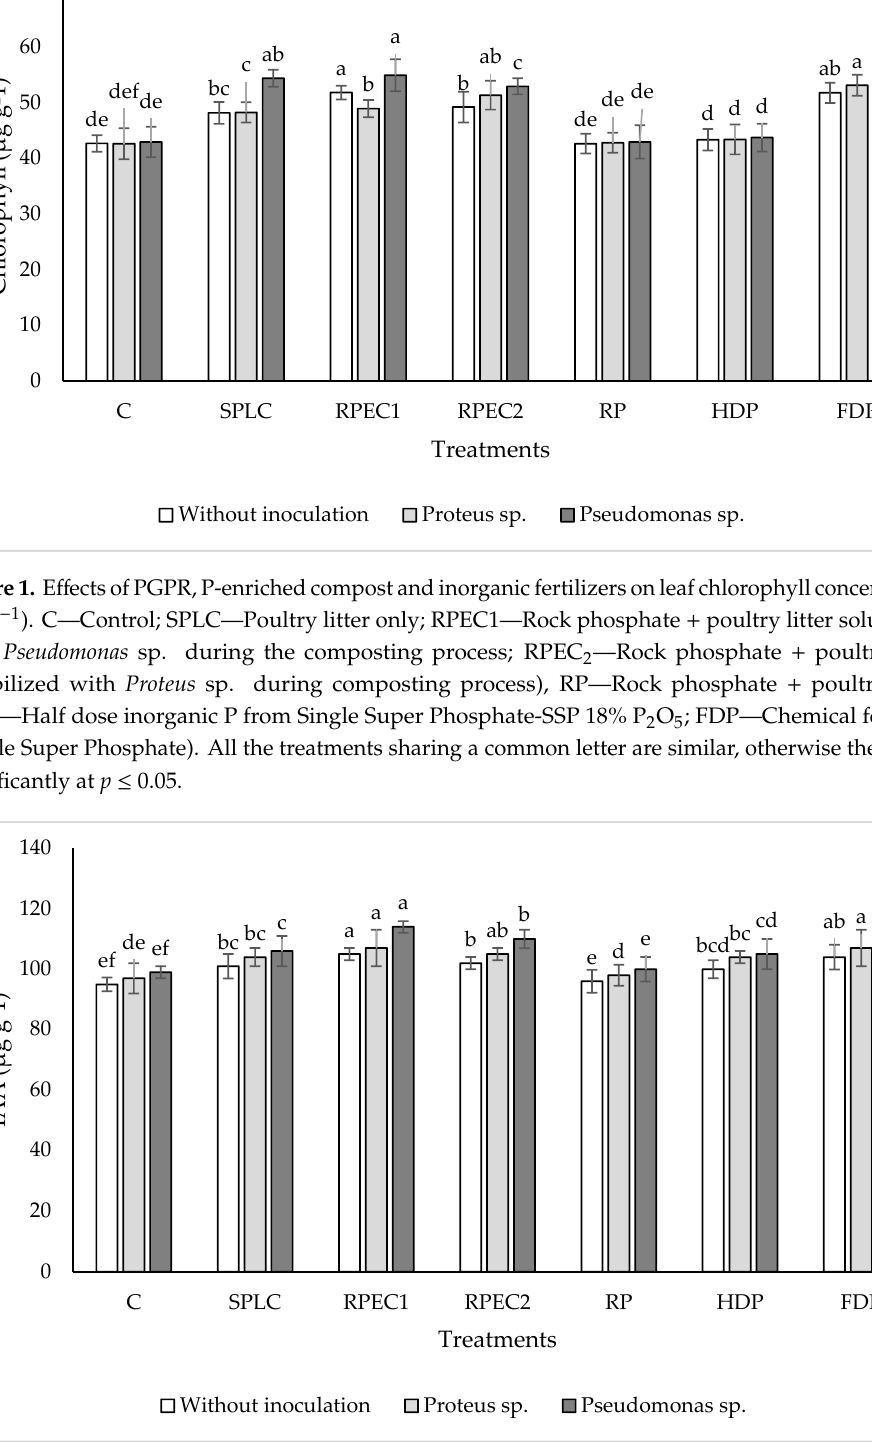
Treatments Proteus sp. Pseudomonas sp. Without inoculation Proteus sp. Pseudomonas sp. Figure 2. Effects of PGPR, P-enriched compost and inorganic fertilizers on leaf IAA concentration (µg g -1 ) in wheat. C-Control; SPLC-Poultry litter only; RPEC1-Rock phosphate + poultry litter solubilized with Pseudomonas sp. during the composting process; RPEC 2 -Rock phosphate + poultry litter solubilized with Proteus sp. during composting process), RP-Rock phosphate + poultry litter; HDP- Half dose inorganic P from Single Super Phosphate—SSP 18% P 2 O 5 ; FDP- Chemical fertilizer (Single Super Phosphate). All the treatments sharing common letter are similar otherwise they differ significantly at p ≤